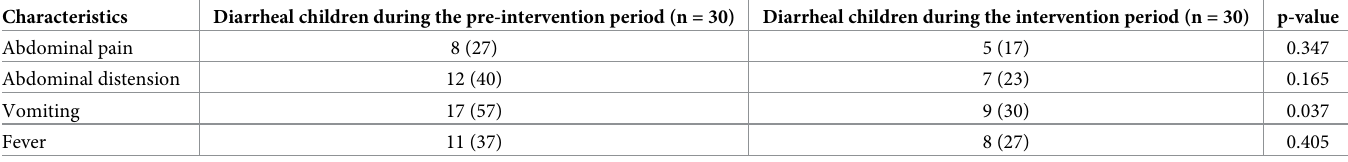
Table 3. Comparison of characteristics of diarrheal children during pre-intervention and intervention period. Characteristics